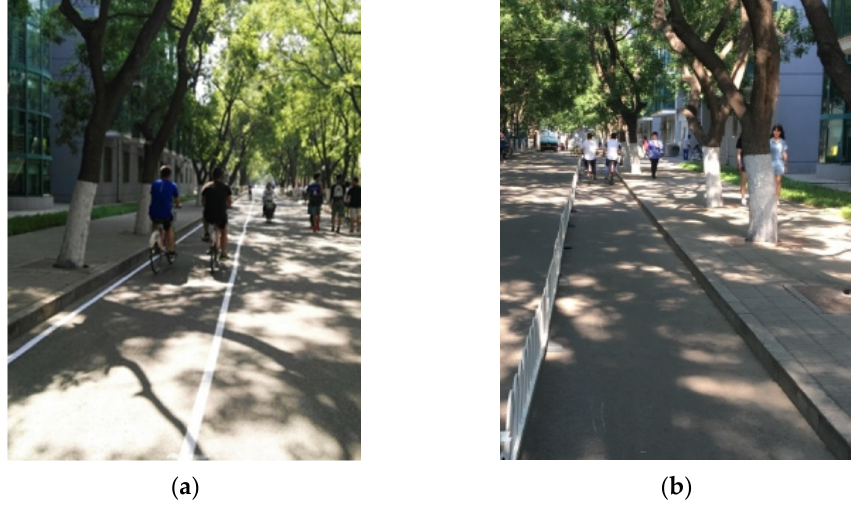
Figure 3. Cycling workload scenarios—different road edges. ( a ) Curb + marking scenario; ( b ) curb